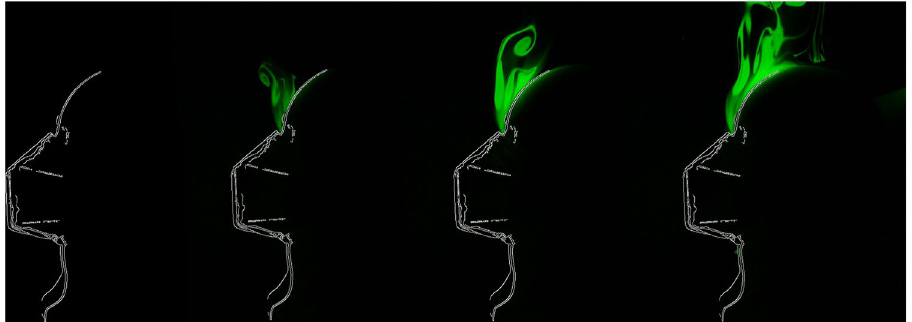
Figure 10. A sequence of four images taken automatically during an experiment a few seconds apart. DEHS aerosol is expelled from behind the mask. Illumination was provided by a 50 mW line laser module (wavelength 530 nm). All images had a still image subtracted from them to show only the aerosol and not the background. Additionally, a Canny edge detection filter was applied to better show the geometry of the head.